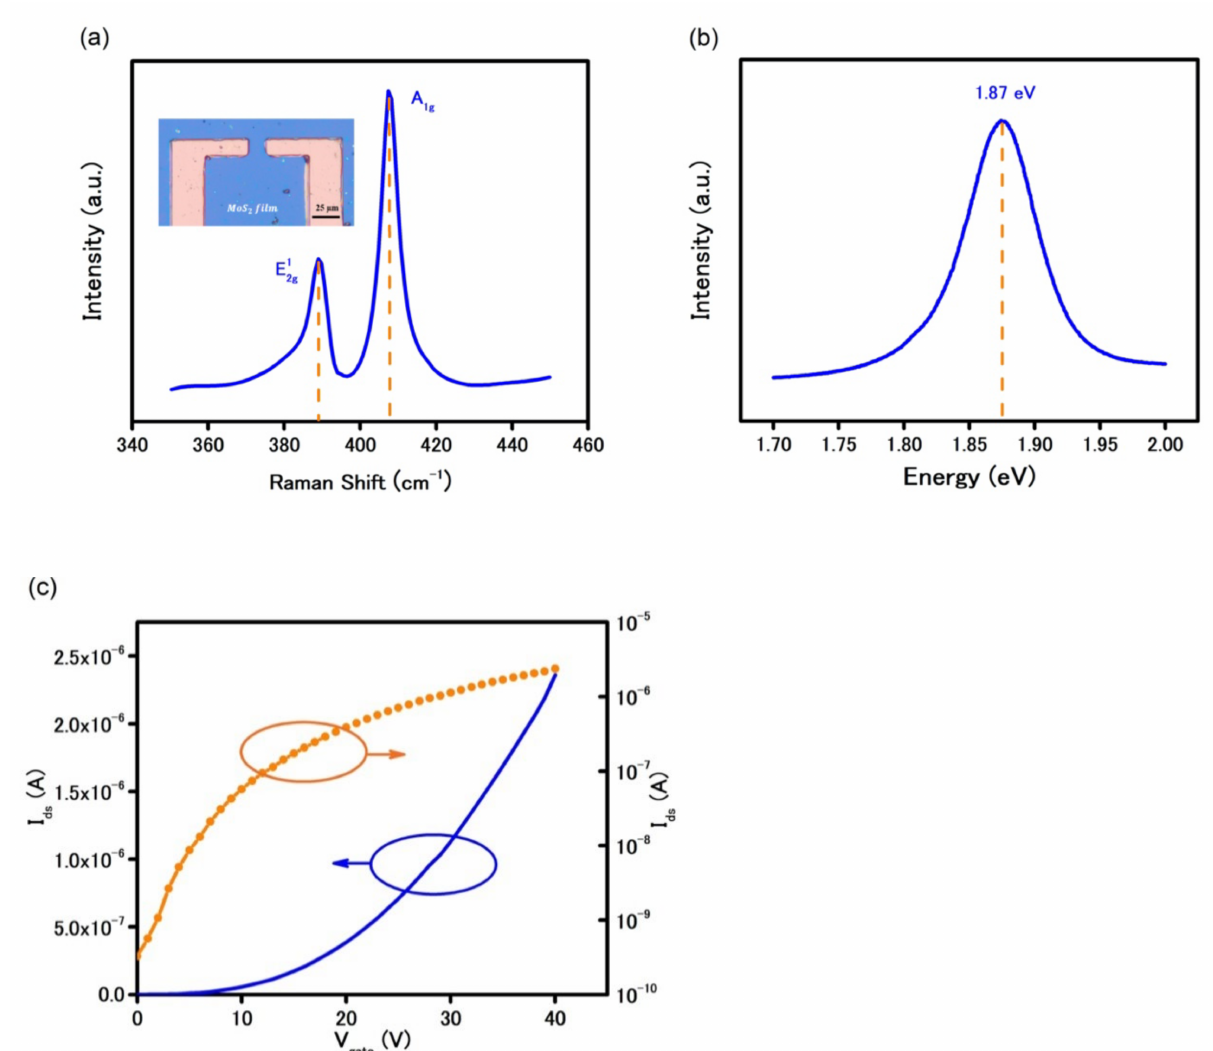
Figure 1. ( a ) Spectroscopic properties of CVD-MoS 2 : Raman spectrum and optical image of MoS 2 device (inset). ( b ) Photoluminescence of CVD-MoS 2 showing a direct band gap of 1.87 eV. ( c ) Field-effect transistor characteristics curve using MoS 2 as the conducting channel (V ds = 5